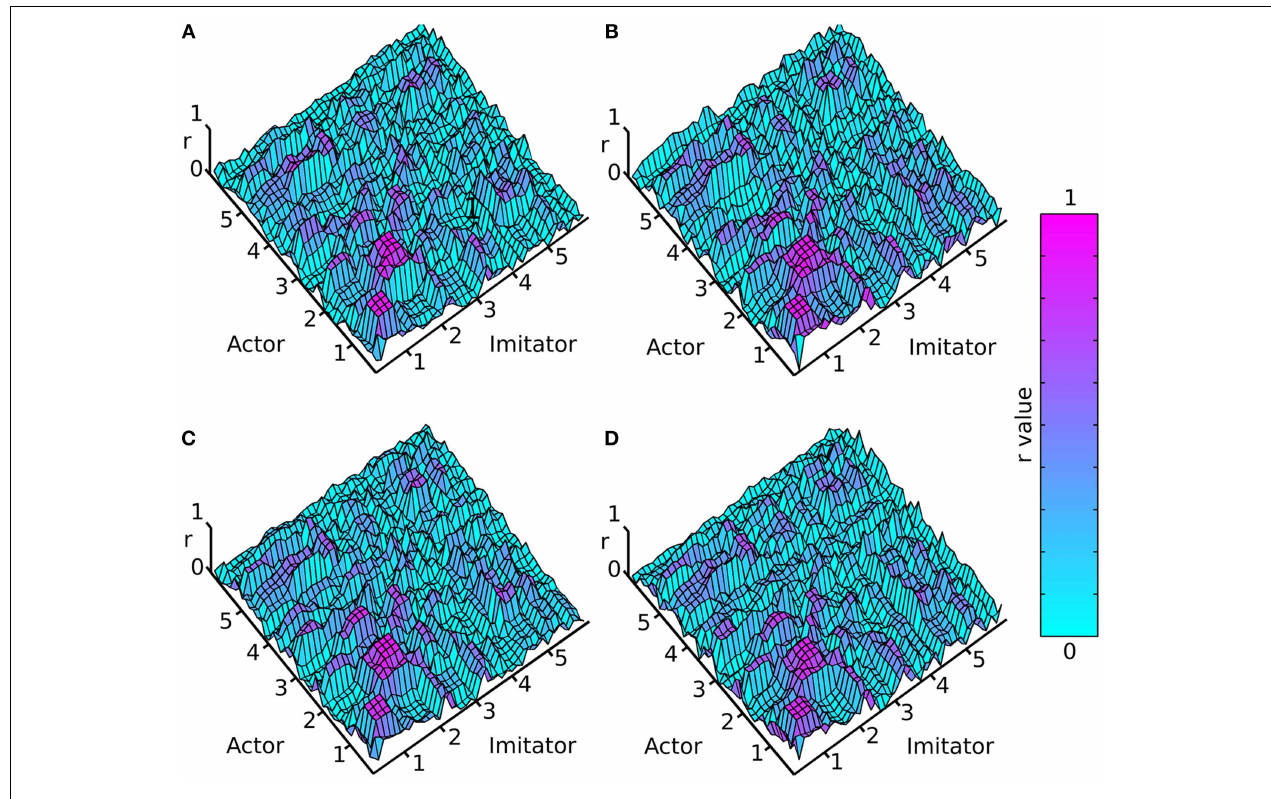
trackers within their degrees of freedom (head, shoulder, elbow, wrist, thumb, index finger, little finger, in x, y, z, azimuth, elevation, and roll): 1 = x, 2 = y, 3 = z, 4 = azimuth, 5 = elevation, 6 =